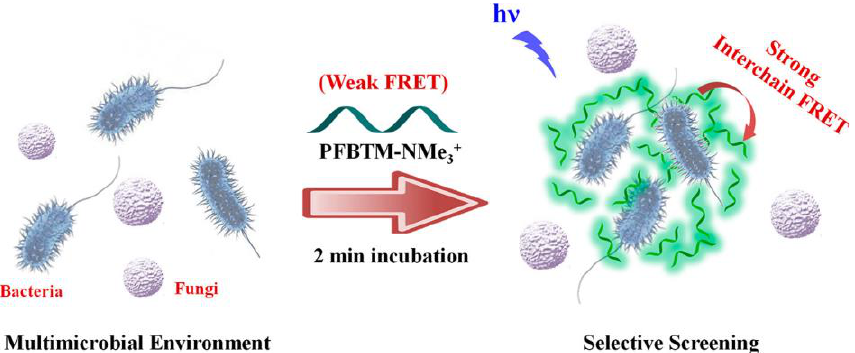
Figure 1. FRET − mediated selective screening and imaging of fungi and bacteria. Figure reproduced from ref. [20] with permission.